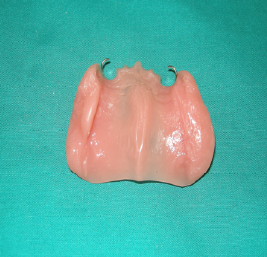
Figure 14. Partial prosthesis in resin with function of palatal plate.